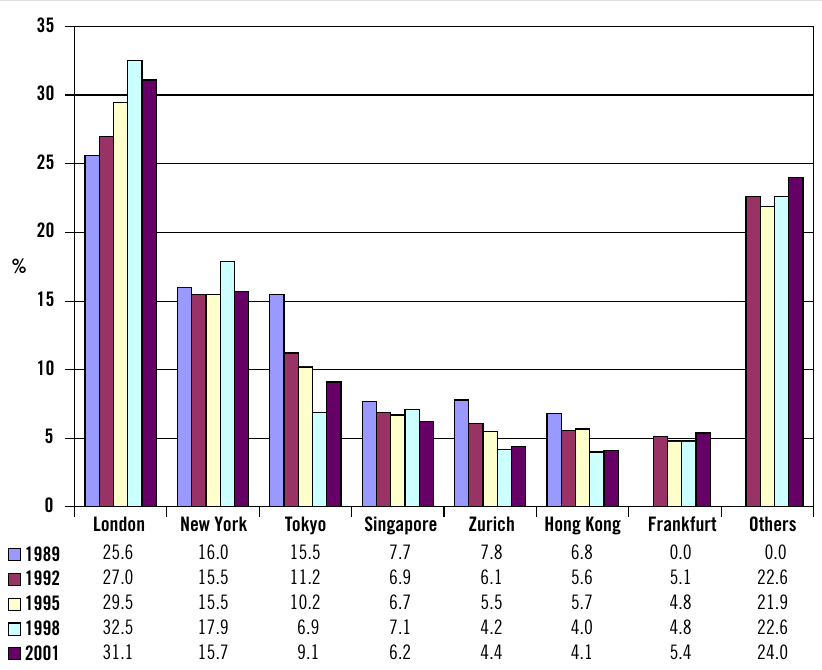
Figure 1 – London: Center of Currency Exchange Figure 2 – Global Currency Exchange by Leading City-Centers,